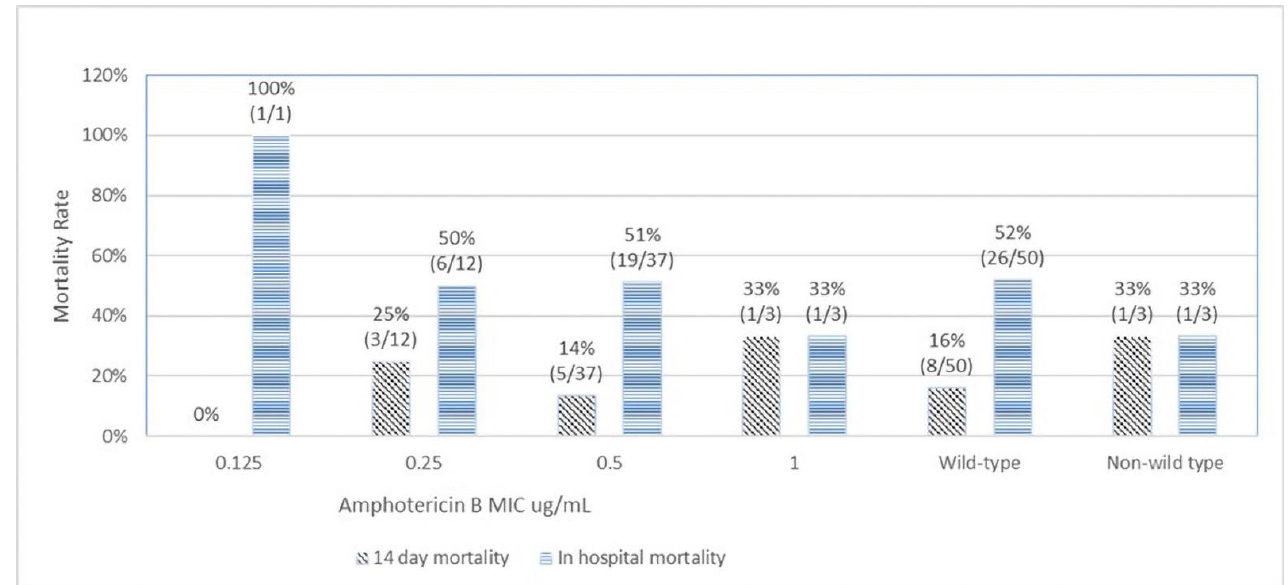
Figure 1. Correlation of amphotericin B minimal inhibitory concentration (MIC) with 14-day and in-hospital mortality.